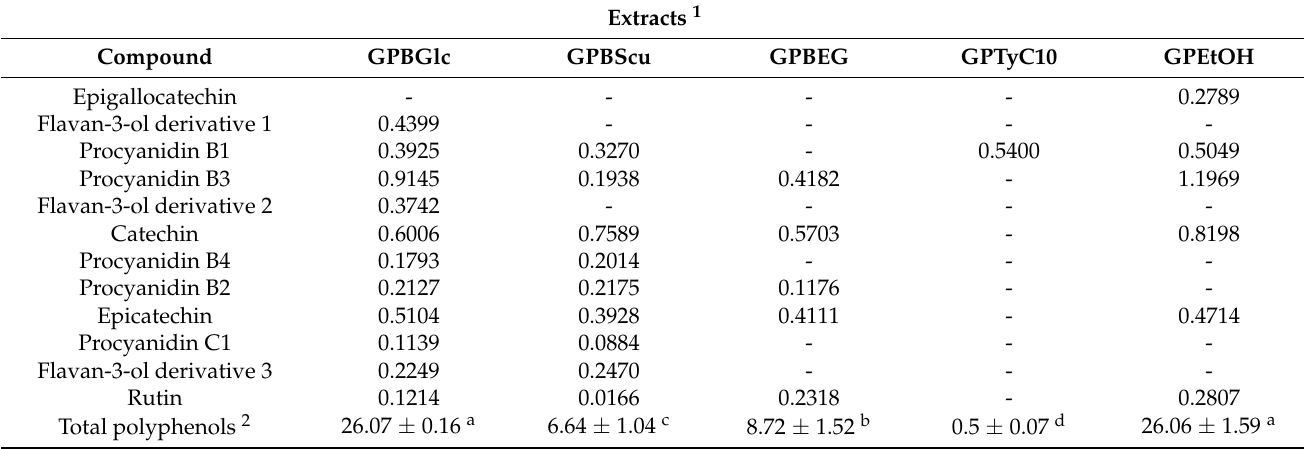
Table 2. Polyphenolic content (mg g dw − 1 of pomace) in prepared extract. Specific polyphenols contents and total polyphenols content were expressed as the means ( n = 3) ±